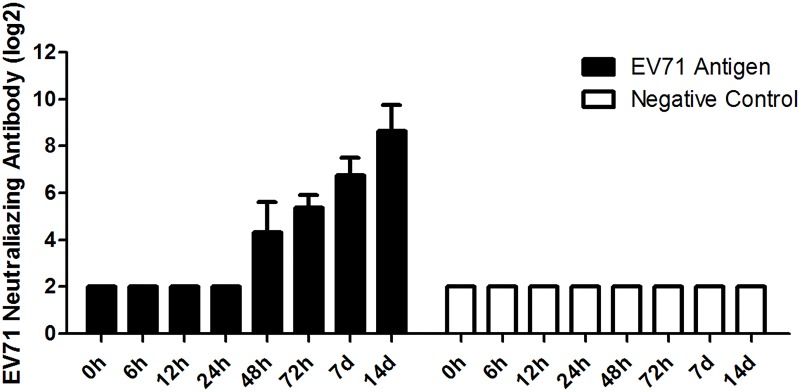
NTAb titer in serum at different time points after vaccination with the EV71 inactivated liquid bulk.Six to eight week-old femal C57BL/6 mice (n = 10 per group) were injected with 400U EV71 inactivated Ag intraperitoneally. PBS was used as negative control and delivered similarly. NTAb titer in serum of each mouse was measured by CPE method at different time points after vaccination (0~14d). The NTAb in mice was initially detected 2d after inoculated, and the NTAb seroconversion rates reached 100% 3d after immunization and persisted up to 14d.